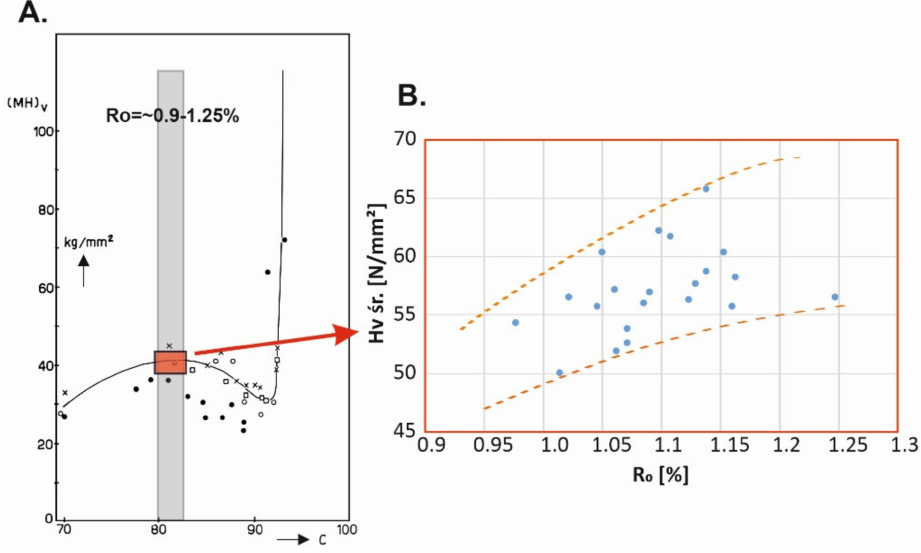
Figure 12. ( A ) Microhardness as a function of coalification of organic matter (according to Stach [28]); ( B ) Microhardness as a function of vitrinite reflectance of the studied coal